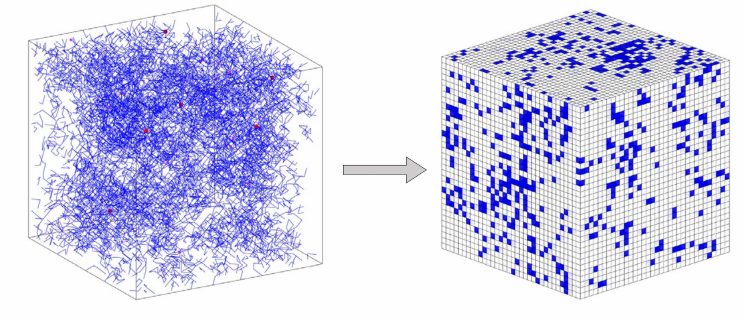
Figure 8. Data representation for model